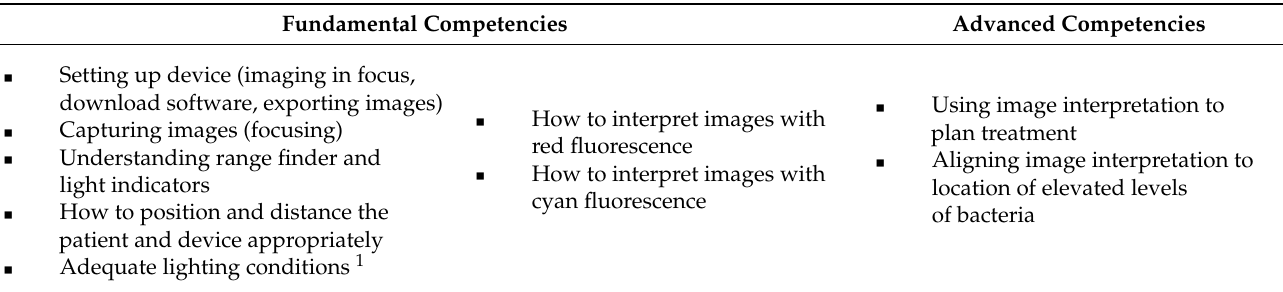
Table 2. Competencies mandatory to perform fluorescence imaging of bacterial burden.